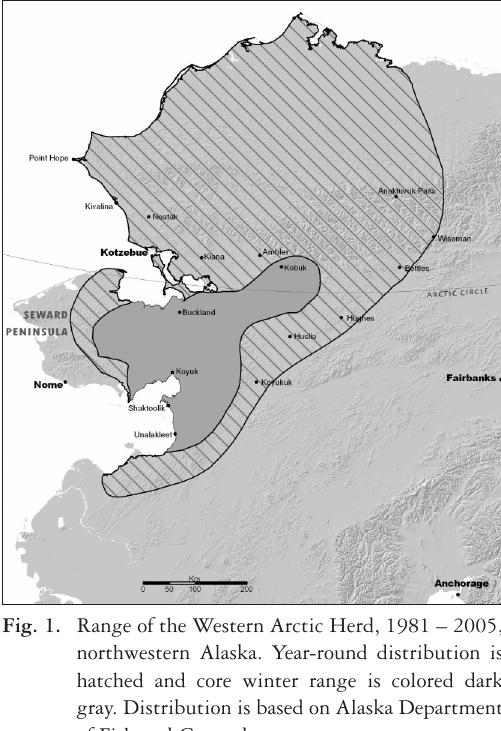
Fig. 2. Locations of the permanent range transects in the Buckland Valley, Seward Peninsula, Alaska. Transects 1 – 20 were deployed in 1981 and 21 – 27 in 1996. Transects #8 and #17 were not re- locatable after